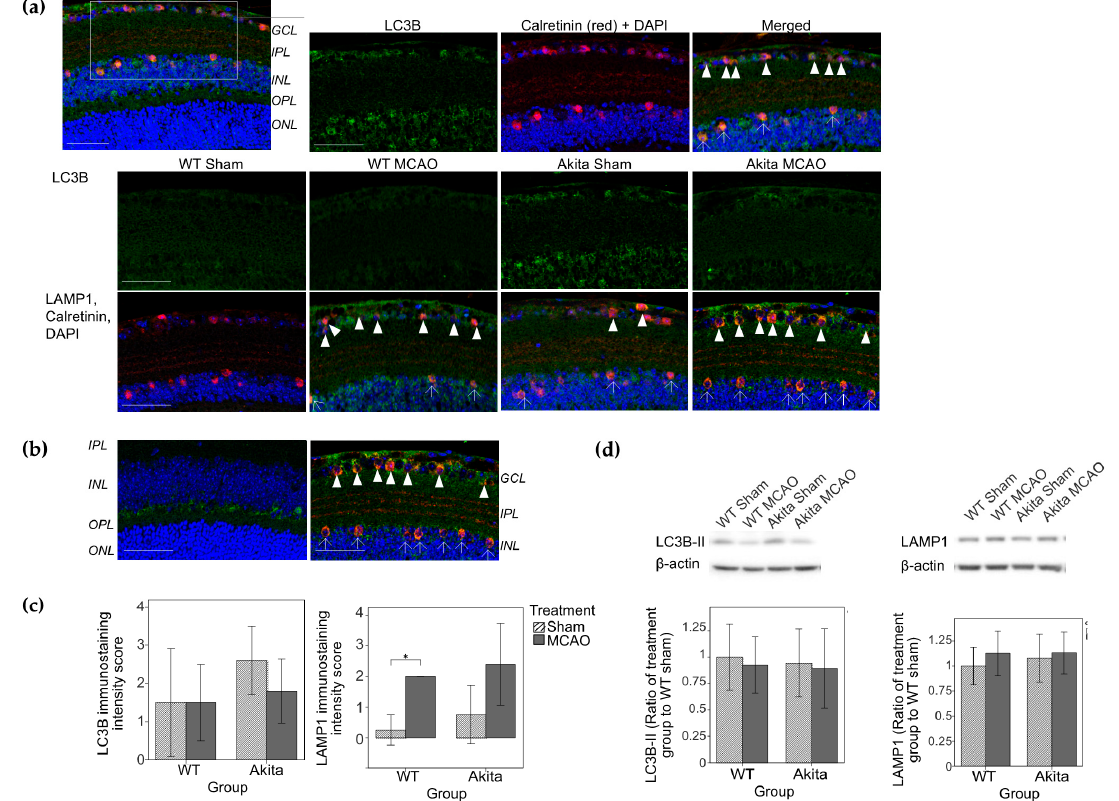
Figure 4. Immunohistochemical staining of calbindin, LC3B, LAMP1, and calretinin, immunohistochemical staining grading of LC3B and LAMP1 and Western blot analysis of LC3B-II and LAMP1 in the 2I22R group. ( a ) Immunohistochemical staining of LC3B (top and middle row) and LAMP1 (bottom row). Double immunolabelling of LC3 and calretinin (amacrine cell marker) showed colocalization of the two markers (arrows) in the GCL and INL of the Akita sham-treated retina sample. Colocalization of LAMP1 (green) and calretinin (red) (shown with DAPI) in the GCL layer (arrowheads) and INL (arrows). LAMP1 immunoreactivity was increased in the GCL and INL of MCAO-injured retinae as compared with sham-treated retinae. Staining of LC3 and LAMP1 was performed on adjacent slides. Scale bars: 50 μ m; ( b ) Immunohistochemical staining of calbindin (left, green, shown with DAPI), LAMP1 and calretinin (right) in Akita MCAO-injured retinae samples to show the localization of horizontal cells. Colocalization of LAMP1 (green) and calretinin (red) (shown with DAPI) in the GCL (arrowheads) and INL (arrows) (same image as shown in Figure 4 ( a ) bottom right corner). LAMP1 was not stained in areas of the horizontal cells. Staining of calbindin and LAMP1 was performed on adjacent slides. Scale bars: 50 μ m; ( c ) Immunohistochemical staining grading of LC3B (left) and LAMP1 (right). Score of 1 represents the weakest immunoreactivity while a score of 4 represented the highest immunoreactivity. * p < 0.05 as compared with WT sham group. n = 5 in each group. Values represent mean with error bars +/ − SD.; ( d ) Western blot analysis of LC3B-II (left) and